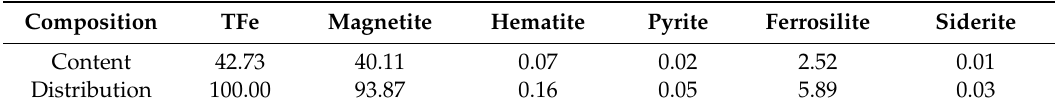
Table 2. Iron phase analysis of oolitic iron ore sample